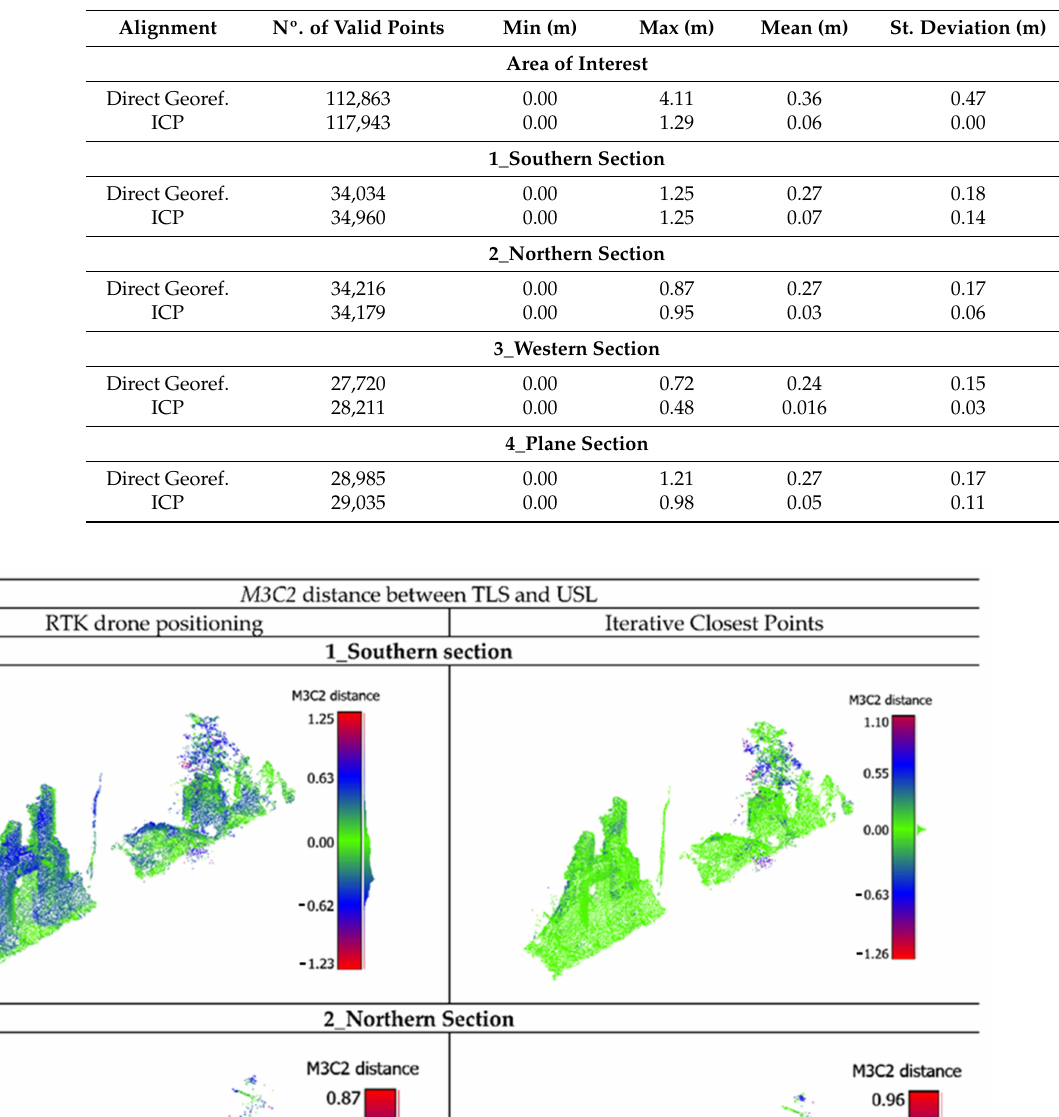
Table 7. Results of M3C2 algorithm. Statistical values of the deviations between FARO Focus 3D X130 and DJI Zenmuse L1 (with direct geo-referencing and after ICP). M3C2 Distance